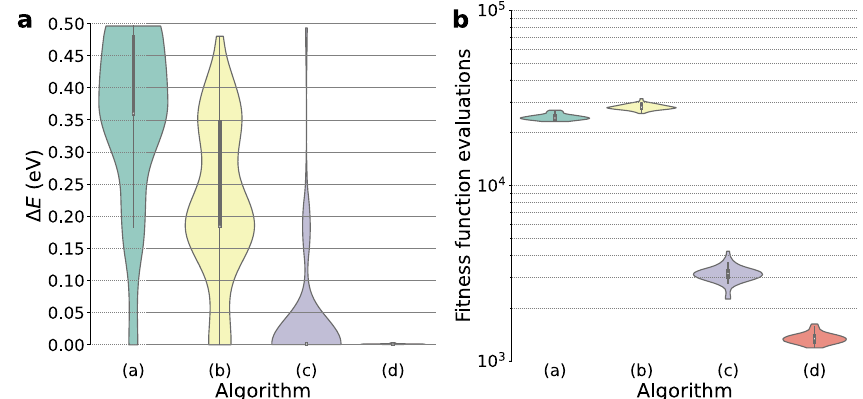
Fig. 1 Comparison of the performance of four different implementations of the CMA-ES. For each of the four implementations 50 independent runs of the algorithm were performed. a The distribution of total energies of the 50 fi nal solutions with respect to the global minimum. b The distribution of the number of fi tness evaluations necessary before such converged solutions are reached. Labels: (a) Original CMA-ES. (b) Initialization of the covariance matrix as per equation (4), without using a hard cutoff. (c) Initialization of the covariance matrix as per equation (4), using a hard cutoff. (d) The fi nal version of the algorithm, as proposed in this work including gradients in the update of the distribution mean. In each violin plot, the white dot represents the median of the distribution, the bold black bar the interquartile range and the thin black lines represents the range of data points comprising the interquartile range extended by a factor of